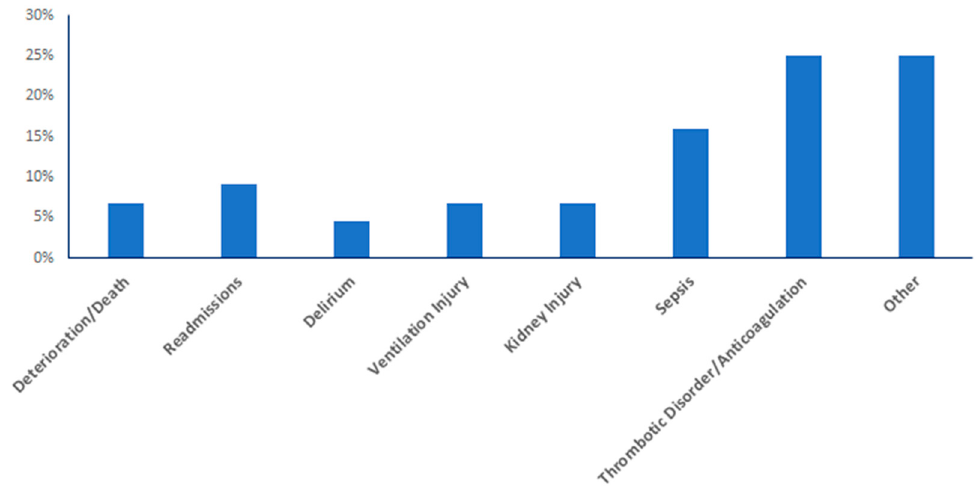
Figure 2. Distribution of studies regarding implementation of EHR-based predictive models based on primary clinical outcome.